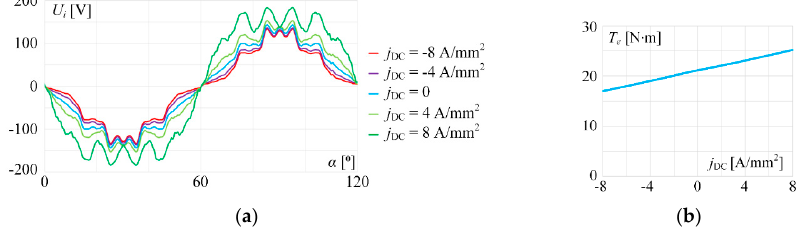
Figure 22. ( a ) No-load back-EMF waveforms at 1000 rpm under di ff erent current density levels; ( b ) Electromagnetic torque means values versus additional windings current density at the stator peak current I s max = 12 A